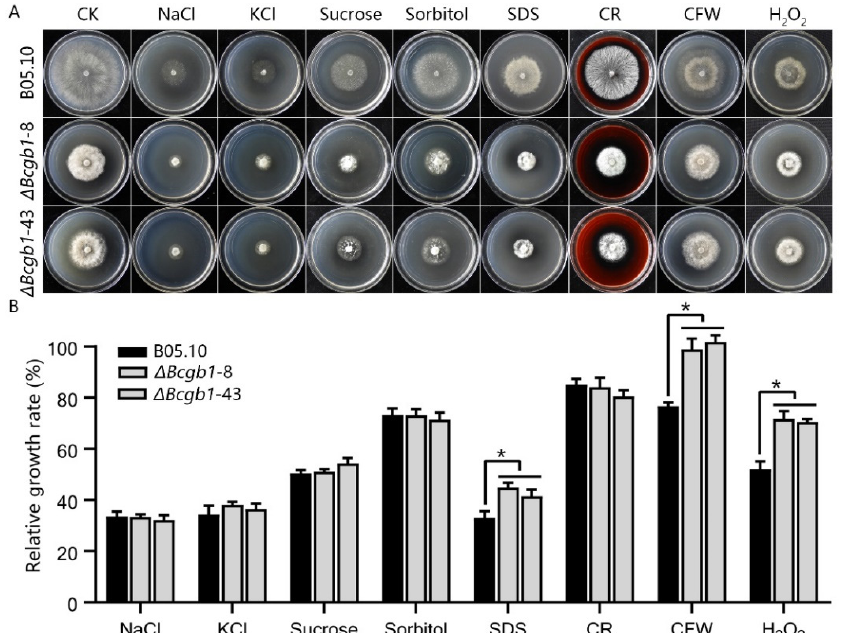
Figure 3. Bcgb1 is involved in responses to cell-wall and oxidative stresses. ( A ) Sensitivity test of strains to salt stress (NaCl or KCl), osmotic stress (sucrose or sorbitol), cell-wall stress (SDS, CR, or CFW), and oxidative stress (H 2 O 2 ). Strains were incubated on PDA supplemented with 1 M NaCl, 1 M KCl, 1 M sucrose, 1 M sorbitol, 0.1 mg/mL SDS, 0.3 mg/mL CR, 0.2 mg/mL CFW, and 5 mM H 2 O 2 at 20 °C for 72 h. ( B ) The relative mycelial growth rate of the indicated strains in the presence of various stresses. * p < 0.05.